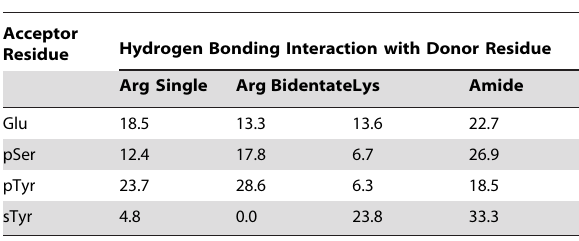
Table 2. Hydrogen Bonding Energies in kcal/mol computed using Implicit Solvation Molecular Mechanics on residue pairs.